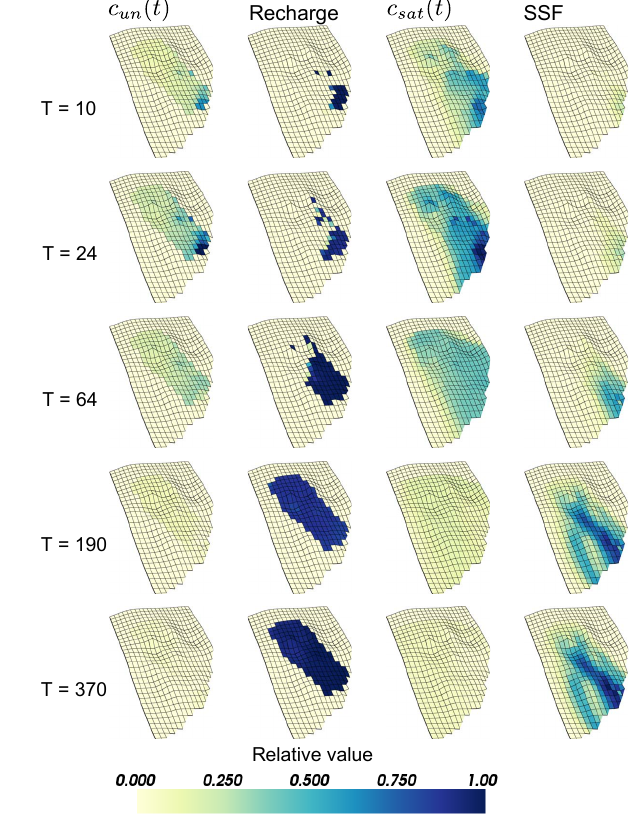
Figure 9. Relative concentration of δ 2 H in the unsaturated zone ( c un (t) ) and the saturated zone ( c sat (t) ), and relative subsurface flow (SSF) and recharge fluxes, at different time slices during the sprinkler experiment. Concentrations are relative to maximum con- centration values at T = 20, and fluxes are relative to maximum flux values at T = 370. Time ( T ) is indicated as hours since the applica- tion of labeled sprinkler